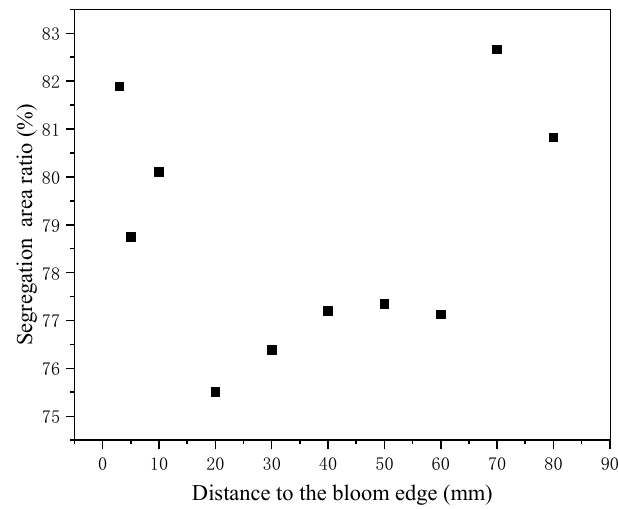
Figure 24. Segregation area ratios of 10 macrostructure positions in Figure 23.